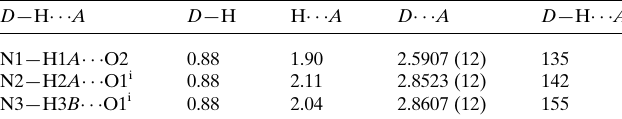
Table 1 Hydrogen-bond geometry (A˚ , (cid:3) ).